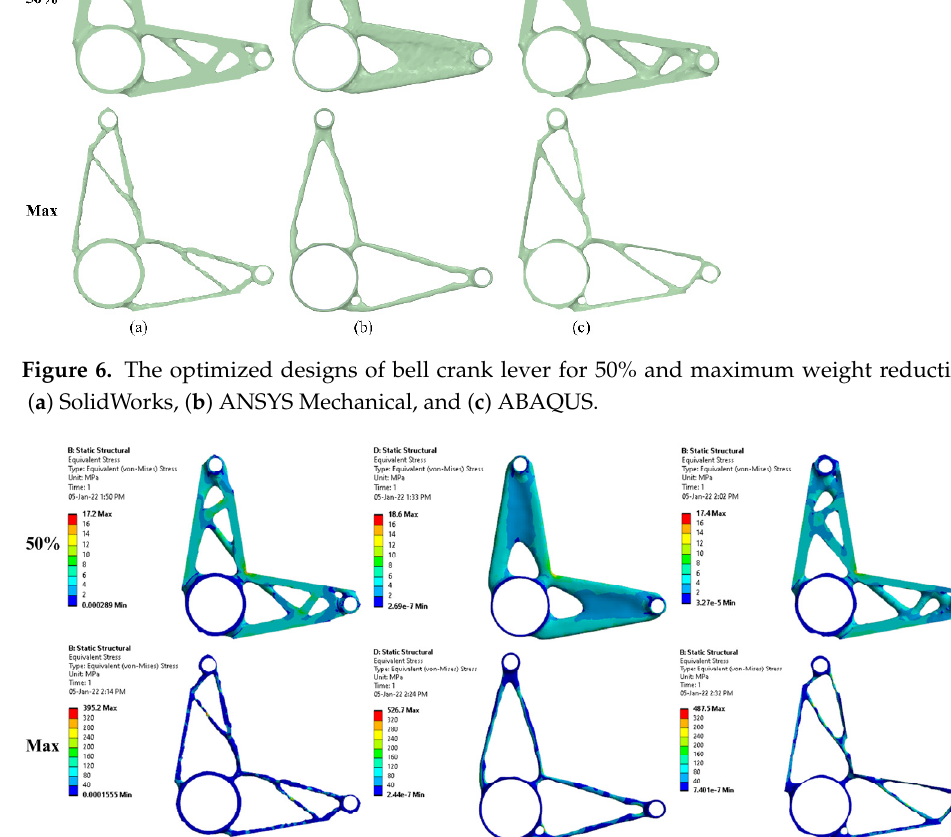
Figure 6. The optimized designs of bell crank lever for 50% and maximum weight reduction in ( a ) SolidWorks, ( b ) ANSYS Mechanical, and ( c ) ABAQUS.